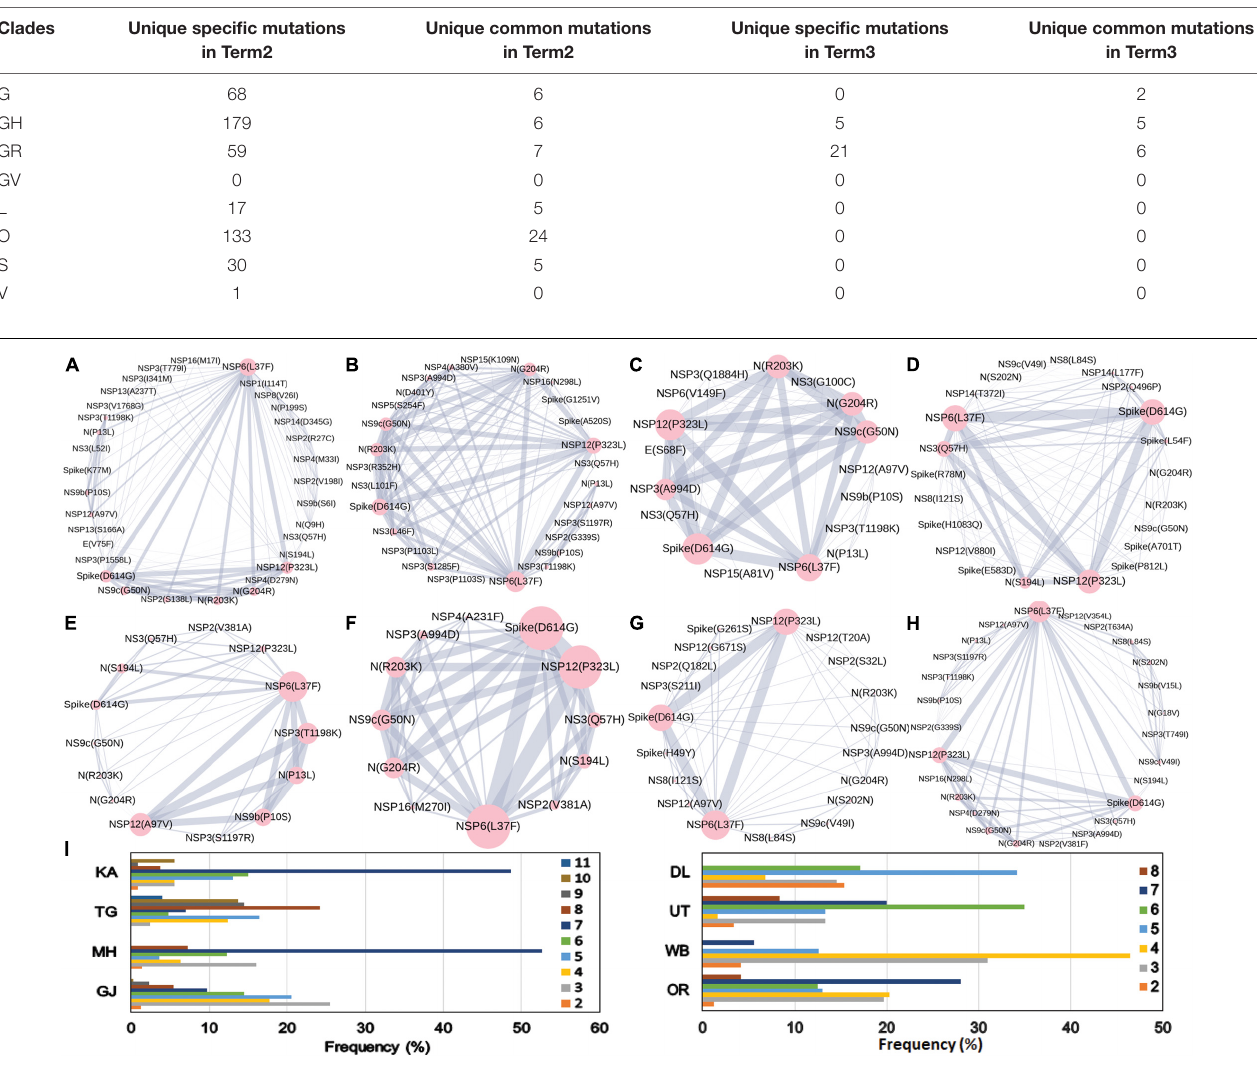
TABLE 2 | Specific and common mutations across different states for different clades.